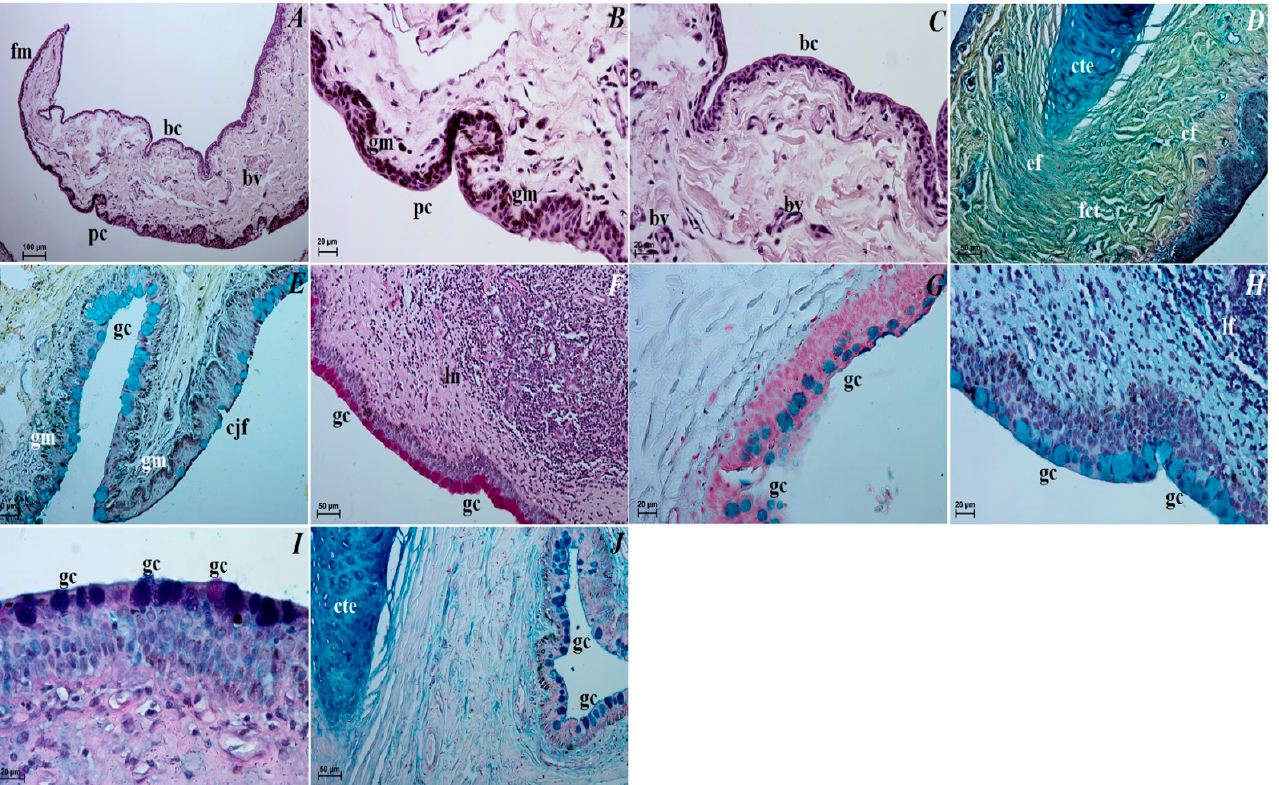
Figure 7. Photomicrograph of the Ursus thibetanus third eyelid. ( A – C ), = H&E; ( D , E ) = Movat pentachrome stain; ( F ) = PAS strongly (+++) positive reaction in the goblet cells; ( G ) = AB pH 1.0 strongly (++/+++) positive reaction in the goblet; ( H ) = AB pH 2.5 strongly (+++) positive reaction in the goblet cells; ( I ) = AB pH 2.5/PAS middle (++, magenta color—neutral mucins) positive reaction in the goblet cells; ( J ) = HDI strongly (+++) positive reaction in the goblet cells. bc—bulbar conjunc-